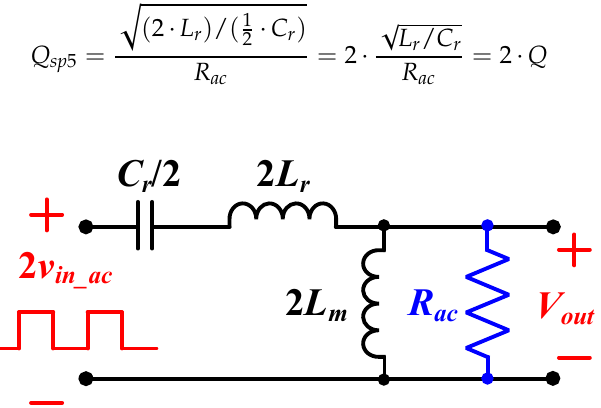
Figure 11. Equivalent circuit of Switching Pattern 5.